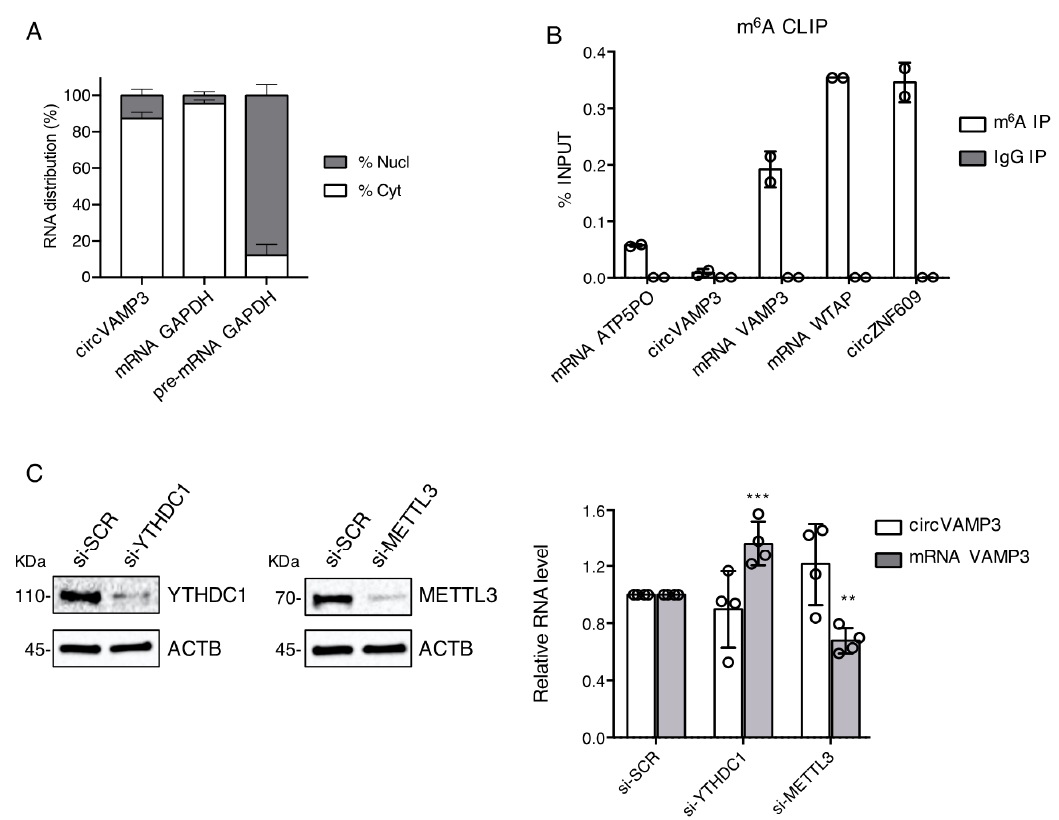
Figure 2. ( A ) Percentage of RNA distribution detected by qRT-PCR in the cytoplasmic (Cyt) and nuclear (Nucl) fractions of RH4 cells for circVAMP3, GAPDH mRNA (cytoplasmic localization control) and GAPDH pre-mRNA (nuclear localization control). Data are represented as mean of fold changes ± standard deviation of three biological replicates. ( B ) RNA levels relative to the input after immunoprecipitation using specific antibodies against either m 6 A RNA modification or IgG. Data are represented as mean ± standard deviation of two biological replicates, with dots representing individual datapoints. ( C ) Left panel: Western blot in RH4 cells in si-SCR, si-METTL3 and si-YTHDC1 conditions to detect YTHDC1, METTL3 and ACTB (loading control) protein levels; representative experiment from four independent replicates; protein molecular weights (KDa) are indicated on the left. Right panel: Relative RNA levels detected by qRT-PCR of circVAMP3 and VAMP3 mRNA in RH4 cells after transfection with either si-SCR, si-YTHDC1 or si-METTL3. Data are represented as mean of fold changes ± standard deviation of four biological replicates, with dots representing individual datapoints. Where statistical analysis was performed, the ratio of each sample versus its experimental control was tested by a two-tailed unpaired Student’s t -test. *: p -value < 0.05, **: p -value < 0.01, ***: p -value < 0.001, ****: p -value < 0.0001.